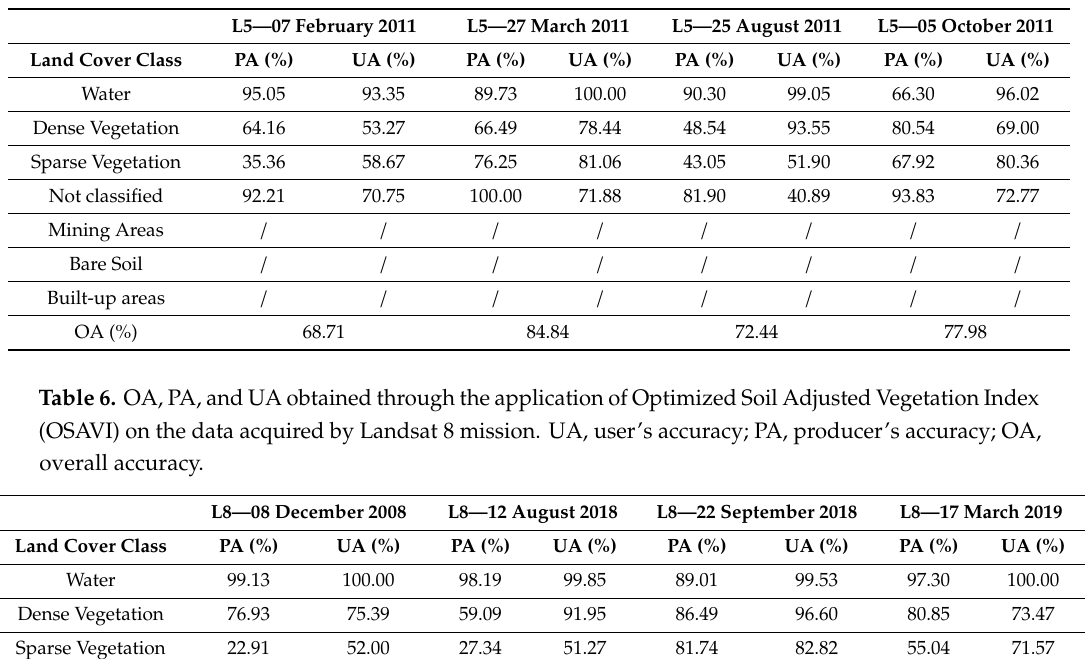
Table 5. OA, PA, and UA obtained through the application of Optimized Soil Adjusted Vegetation Index (OSAVI) on the data acquired by Landsat 5 mission. UA, user’s accuracy; PA, producer’s accuracy; OA, overall accuracy.